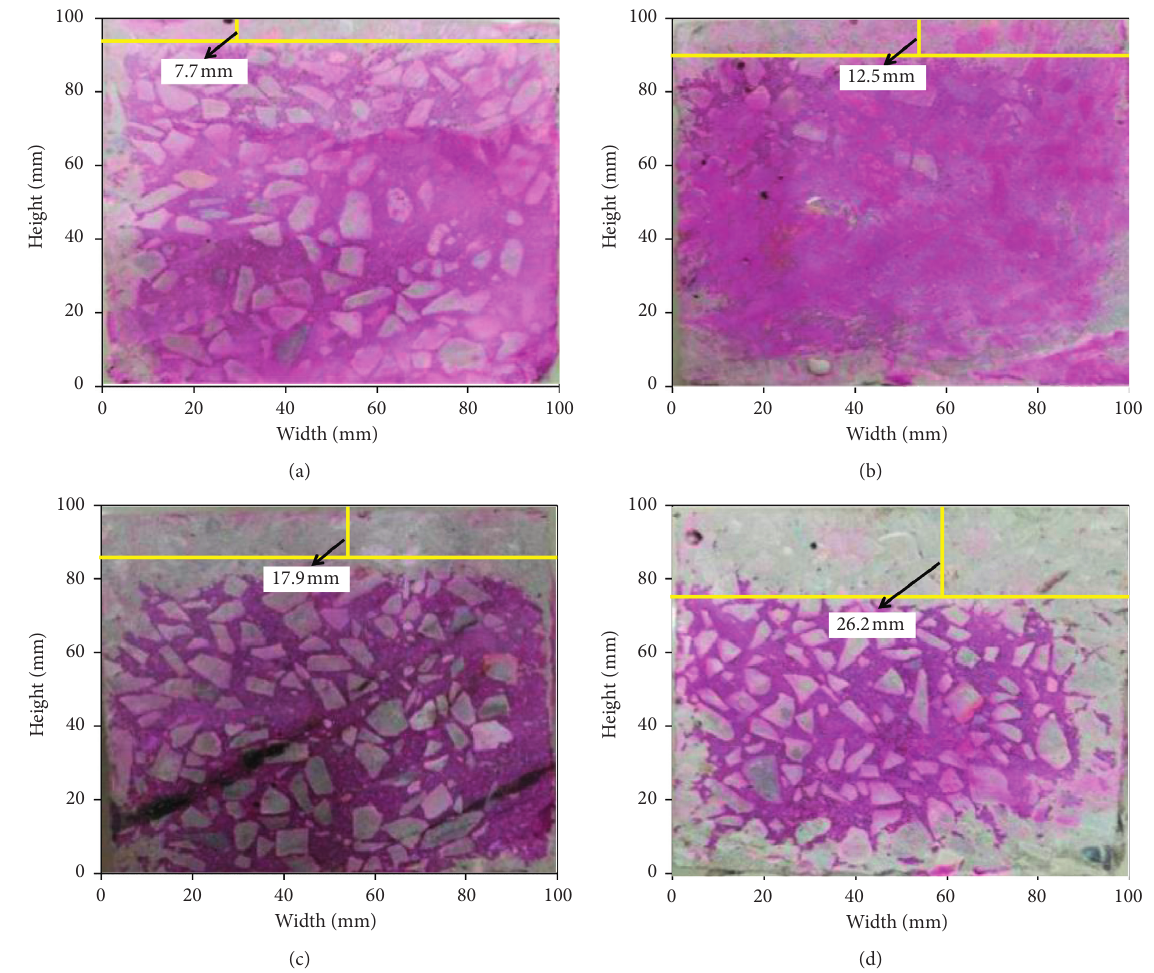
Figure 5: Carbonation depth of hybrid fiber concrete with 30% fly ash substitution rate: (a) 3d carbonization depth, (b) 7d carbonization depth, (c) 14d carbonization depth, and (d) 28 d carbonization depth.